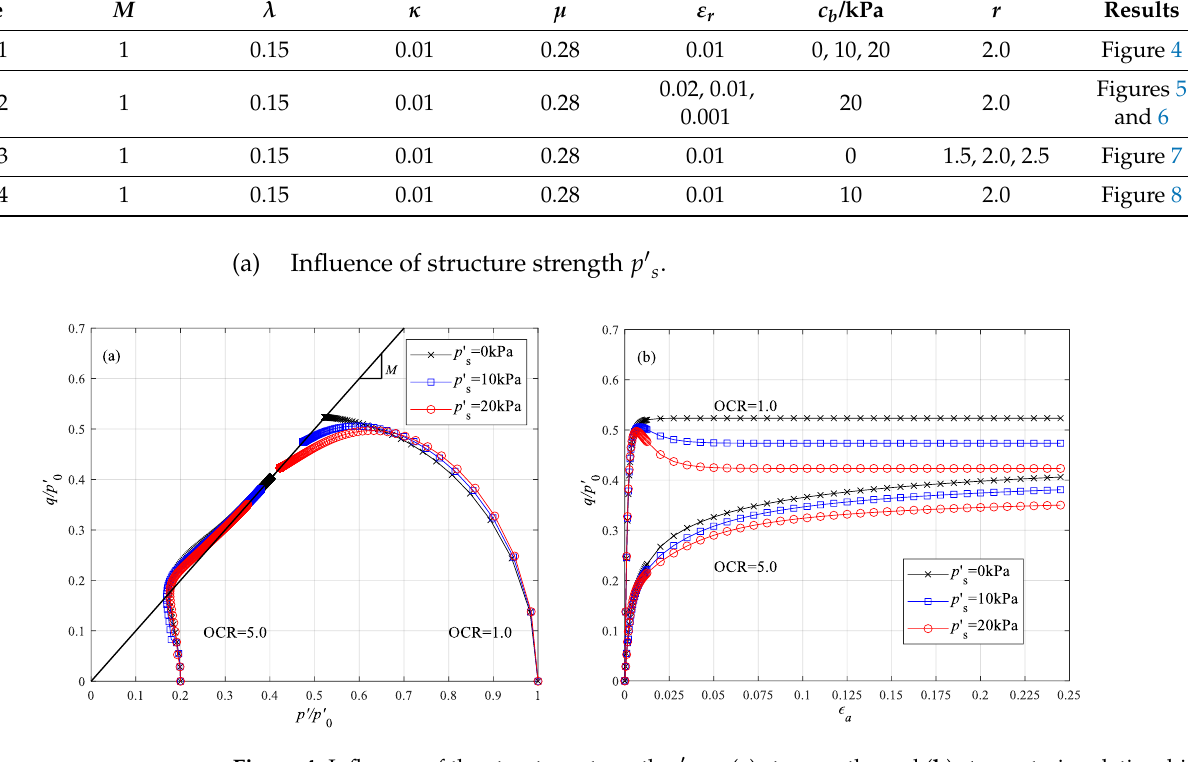
Figure 5. Influence of the reference strain ε r on ( a ) stress paths and ( b ) stress-strain relationships.